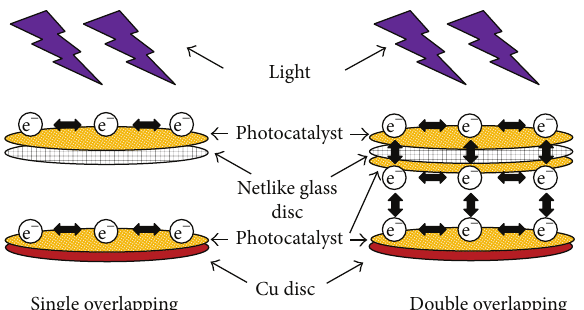
Figure 13: Comparison of electron transfer phenomena between single and double overlapping.